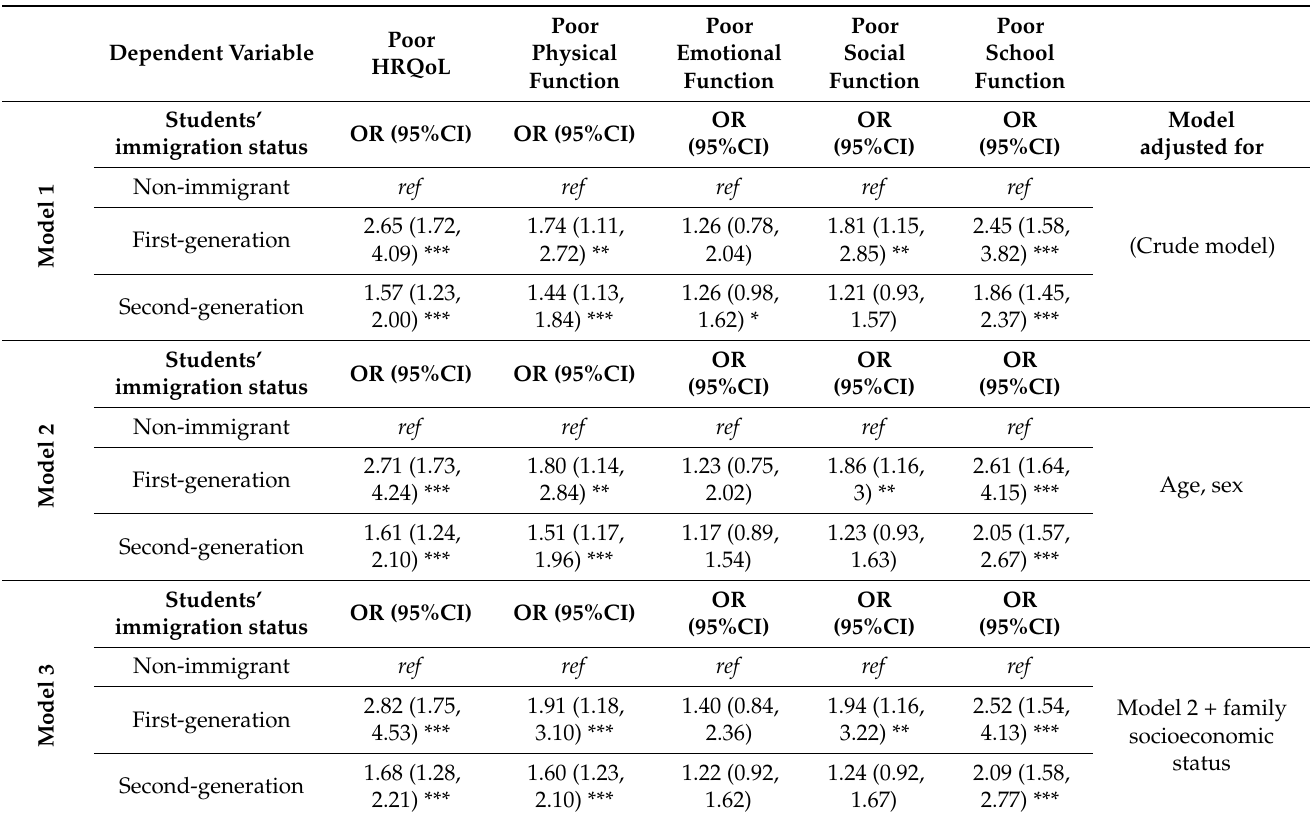
Table 3. Logistic regression models evaluating the association between immigration status and parent-perceived quality of life of students participating in the DIATROFI